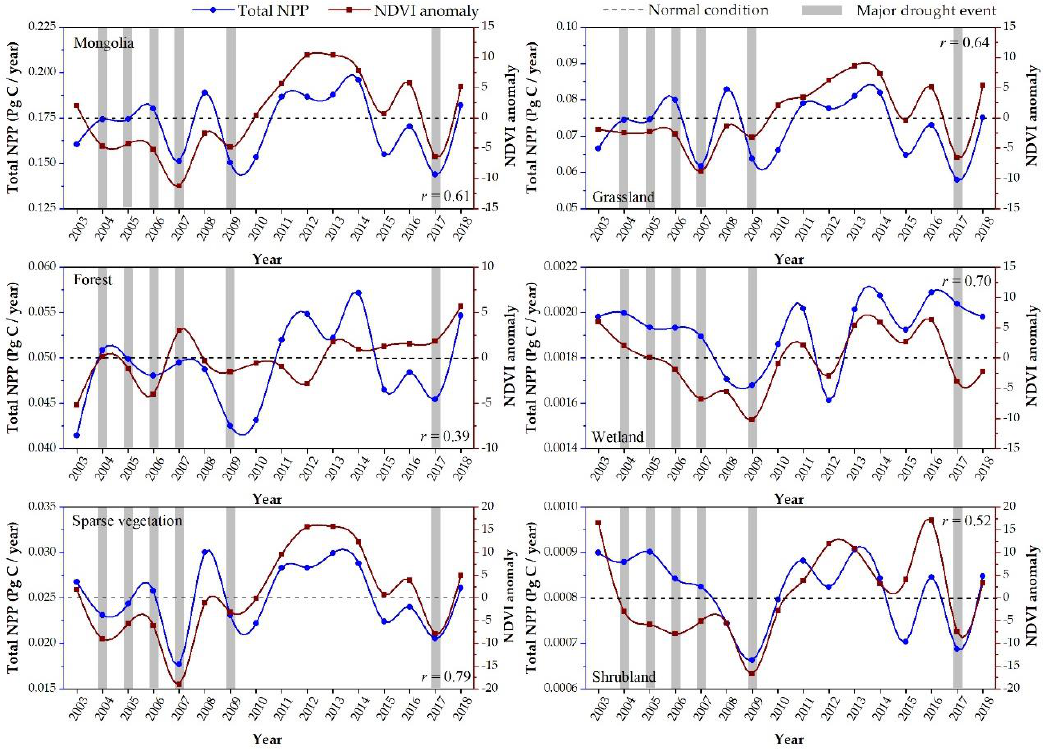
Figure 8. Time series of growing season total NPP (blue) and area percentage of drought-affected areas (red) in Mongolia from 2003 to 2018. The gray column represents the major drought events (area >60% of the total land).